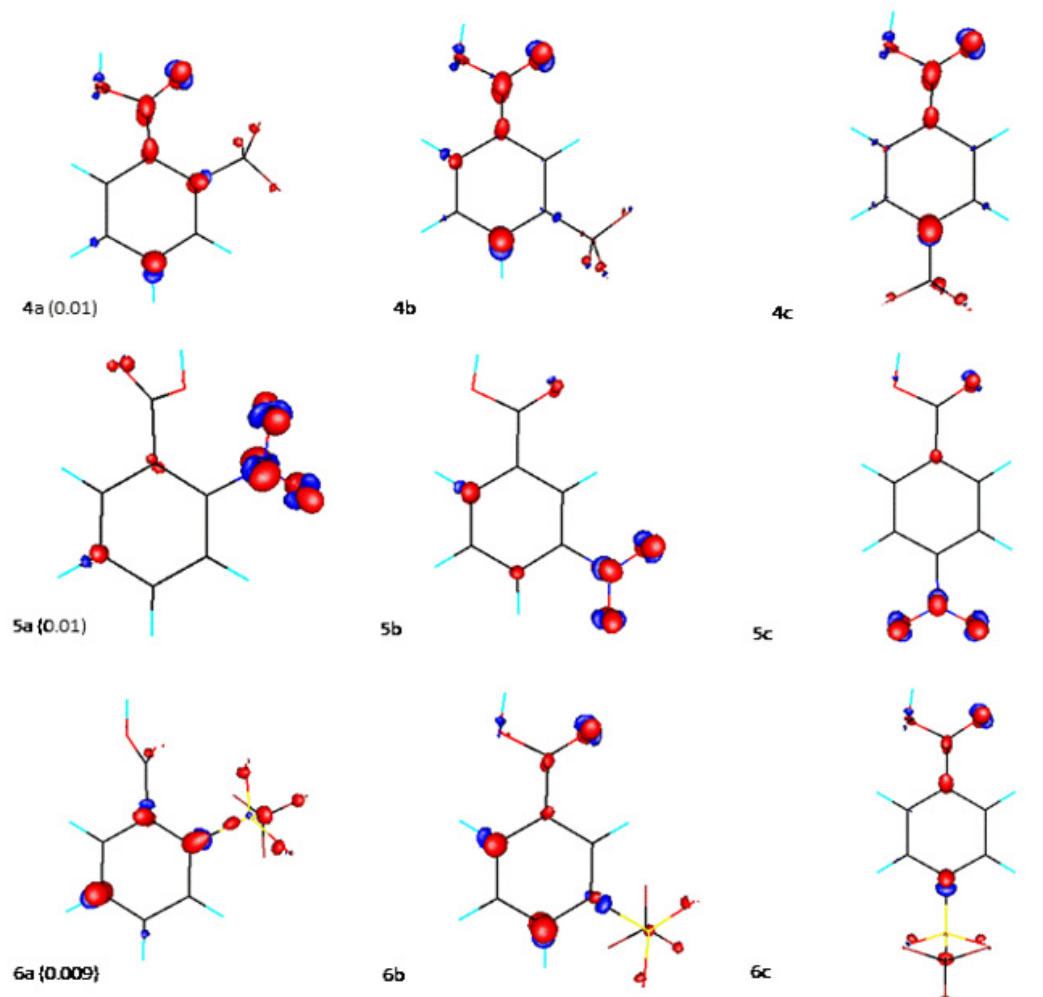
Figure 4. The surface plot of the nucleophilic Fukui function f + ( r ) for the benzoic acids with electron-withdrawing substituent ( 4a – 6c) .